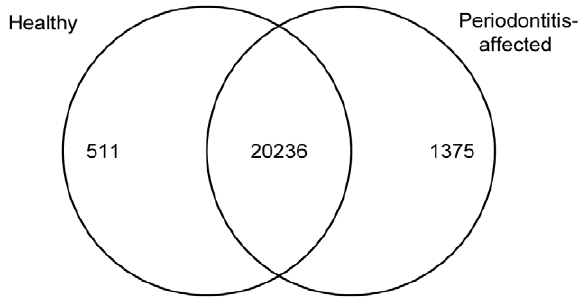
Figure 3. Venn diagram of mRNA transcripts. Venn diagram showing genes that were uniquely expressed in periodontitis-affected (1375) and healthy (511) gingival tissues. The intersection of the two circles refers to transcripts, which are expressed in both periodontitis- affected and healthy gingival tissues (20 236).